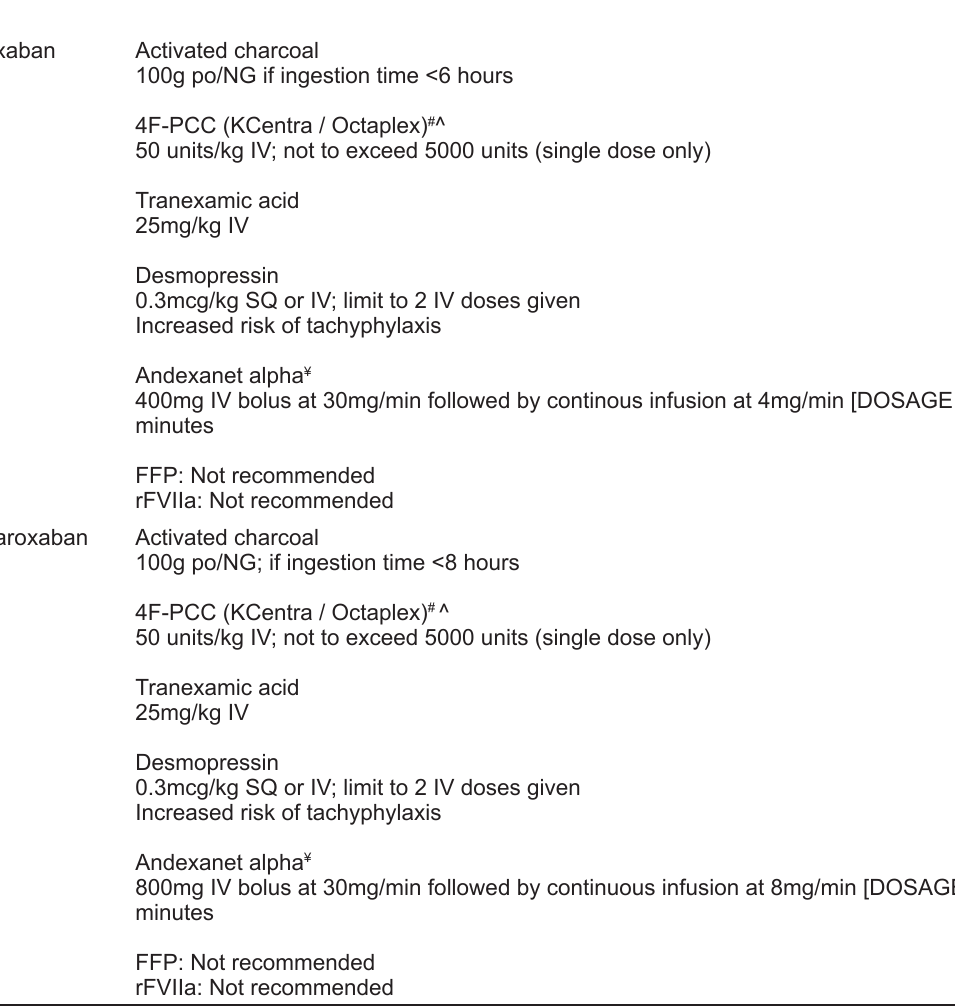
Figure 3. Reversal of direct oral anticoagulants (DOACs) in patients with significant bleeding. IV, intravenous; FFP , fresh frozen plasma; rFVIIa , Recombinant human Factor VIIa ; PCC , prothrombin complex concentrates; FEIBA , Factor Eight Inhibitor Bypassing Activity; NG , nasogastric #Off label